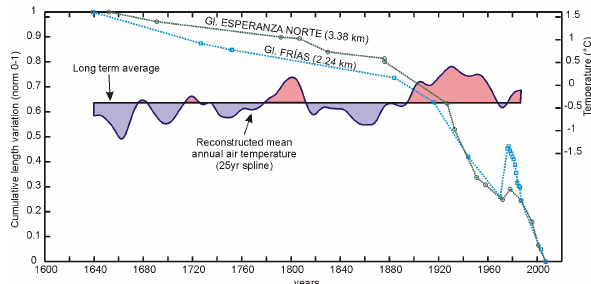
Fig. 6. Variations in area (A) and length (B) of Glaciar Esperanza Norte since the LIA. Horizontal error bars (dating uncertainties of the moraines) were estimated based on the difference between their minimum age obtained after corrections and the innermost ring date observed in the tree-ring samples (see Sect. 4 for further discus- sion). Area and length inaccuracies (vertical error bars) reflect the spatial resolution of the information available (see Table 2).